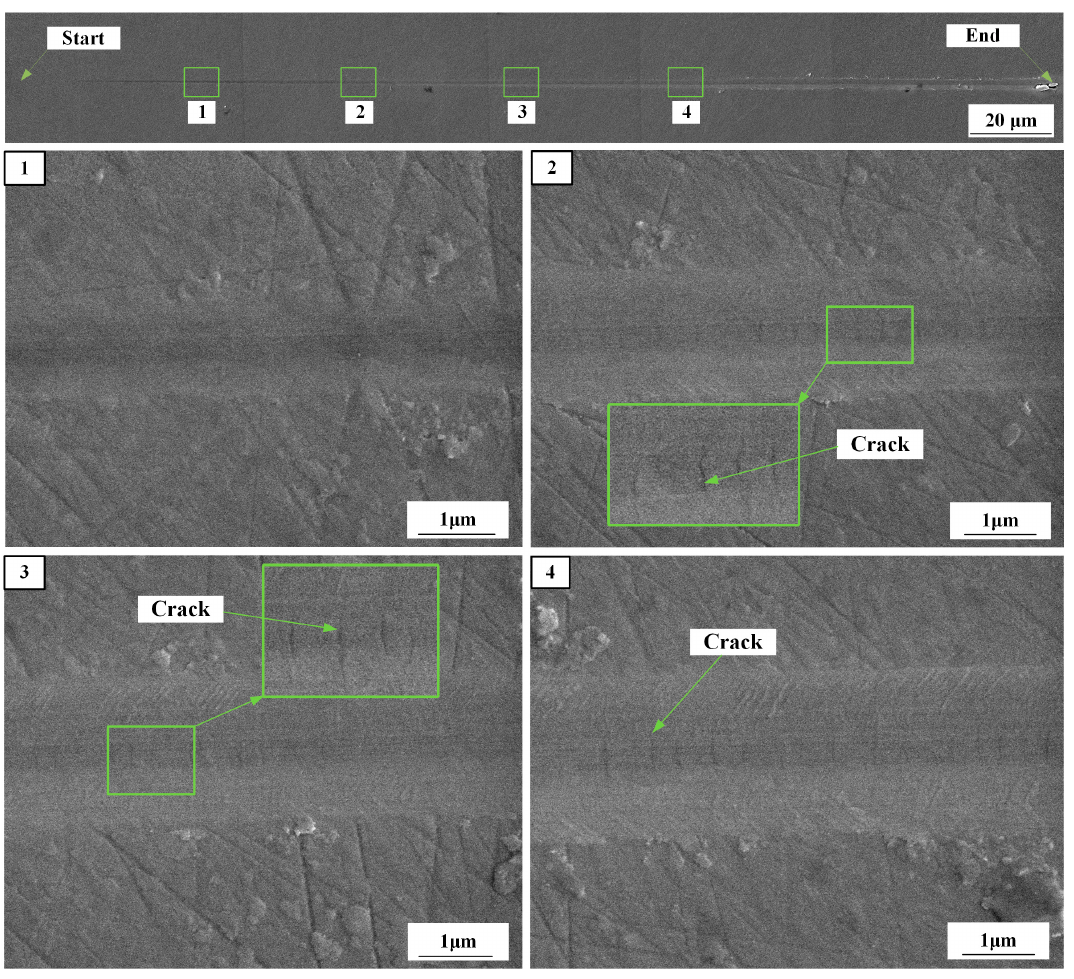
Figure 5. Full view and enlarged image of a scratch using SEM.